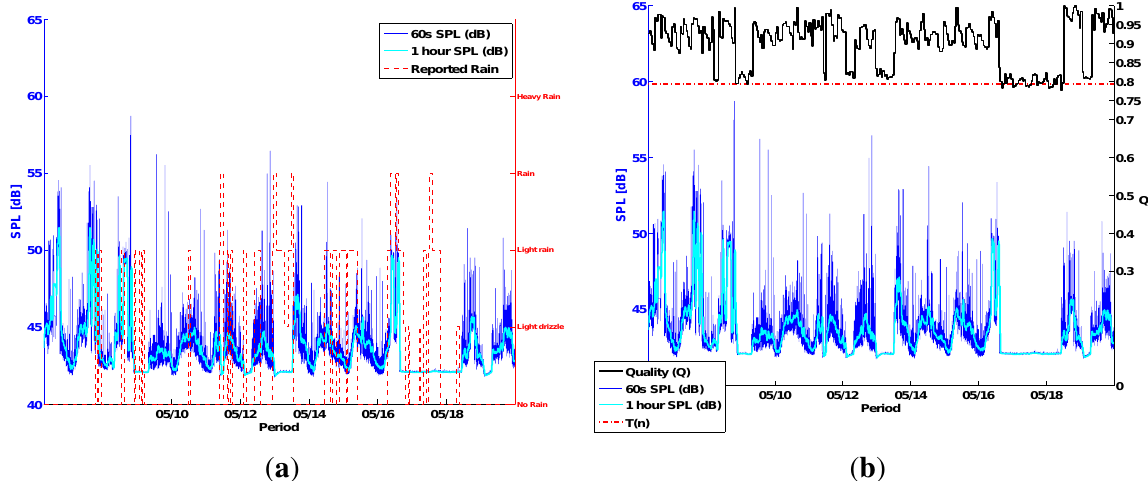
Figure 14. Seven failure scenarios in Test node 1 are shown here for a period of two weeks. Plot ( a ) shows the sensor’s output superimposed with weather data, suggesting that rain caused all observed failures. A plot of the same period, superimposed with Q values ( b ), shows that Q barely reaches T ( n ) during the observed sensor failures. ( a ) Sensor failures Test Node 1 and weather (MC); ( b ) Sensor failures Test node 1 and Q